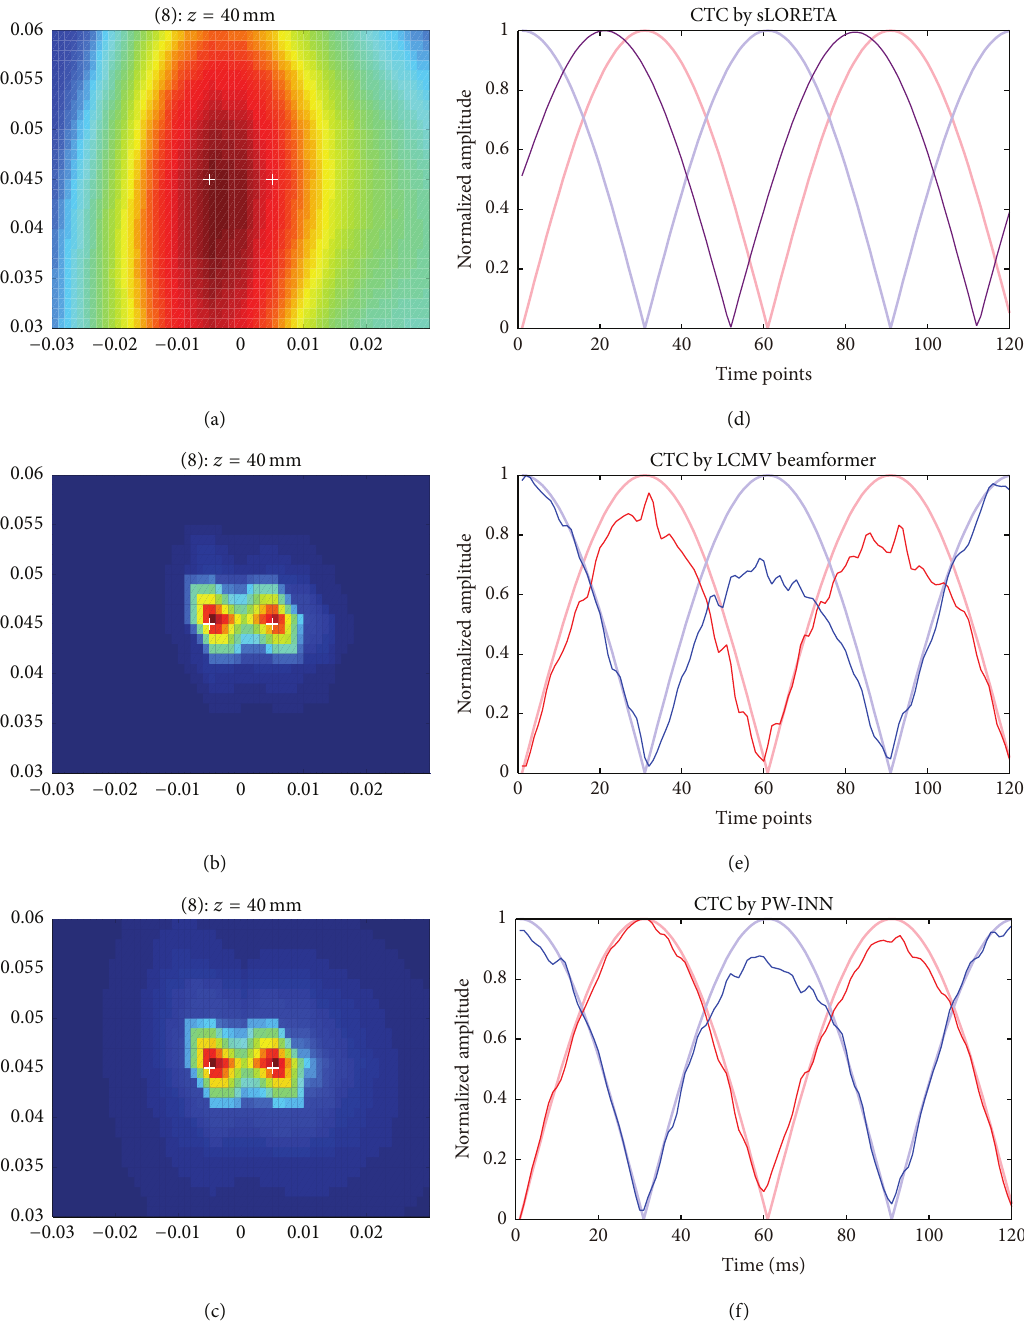
Figure 5: Source reconstruction using sLORETA, LCMV beamformer, and PW-INN. Source locations were the same as those in Figure 2. Real MEG noise was added such that SNR = 18. Two simulated source time courses have phase difference of 90 degrees. The correlation 𝑟 2 between sources is 0. (a)–(c) Source distribution estimated from sLORETA (a), LCMV beamformer (b), and PW-INN (c). White crosses indicate the true source locations. (d)–(f) Source time courses at the peak locations estimated from sLORETA (d), LCMV beamformer (e), and PW-INN (f). The time courses in (d)–(f) are the norm of the original time courses over 𝑥𝑦𝑧 -axis (i.e., collecting time courses, CTC). Bold lines in light red and light blue indicate the true source time courses and thin lines in red and blue indicate the estimated ones. The purple color line in (d) indicates the time course from the wrongly estimated equivalent